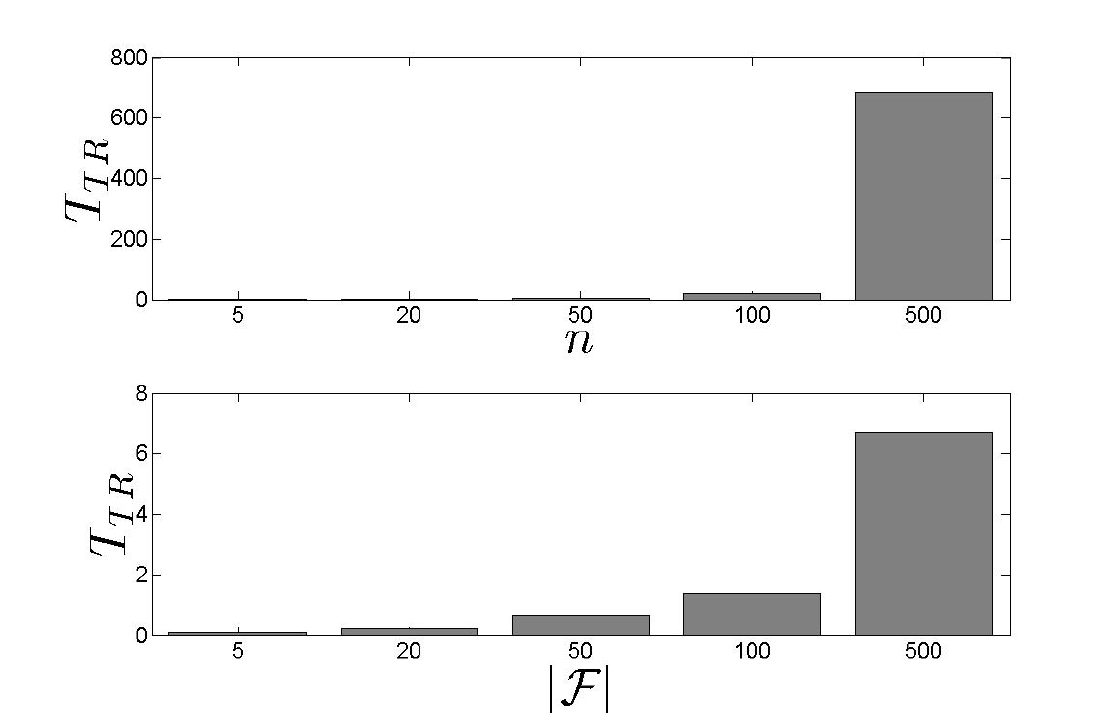
Figure 3. The RLS training